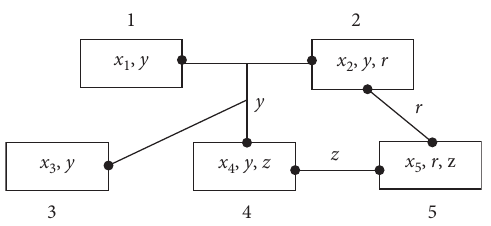
Figure 1: Decomposition structure with five subsystems and three coupling